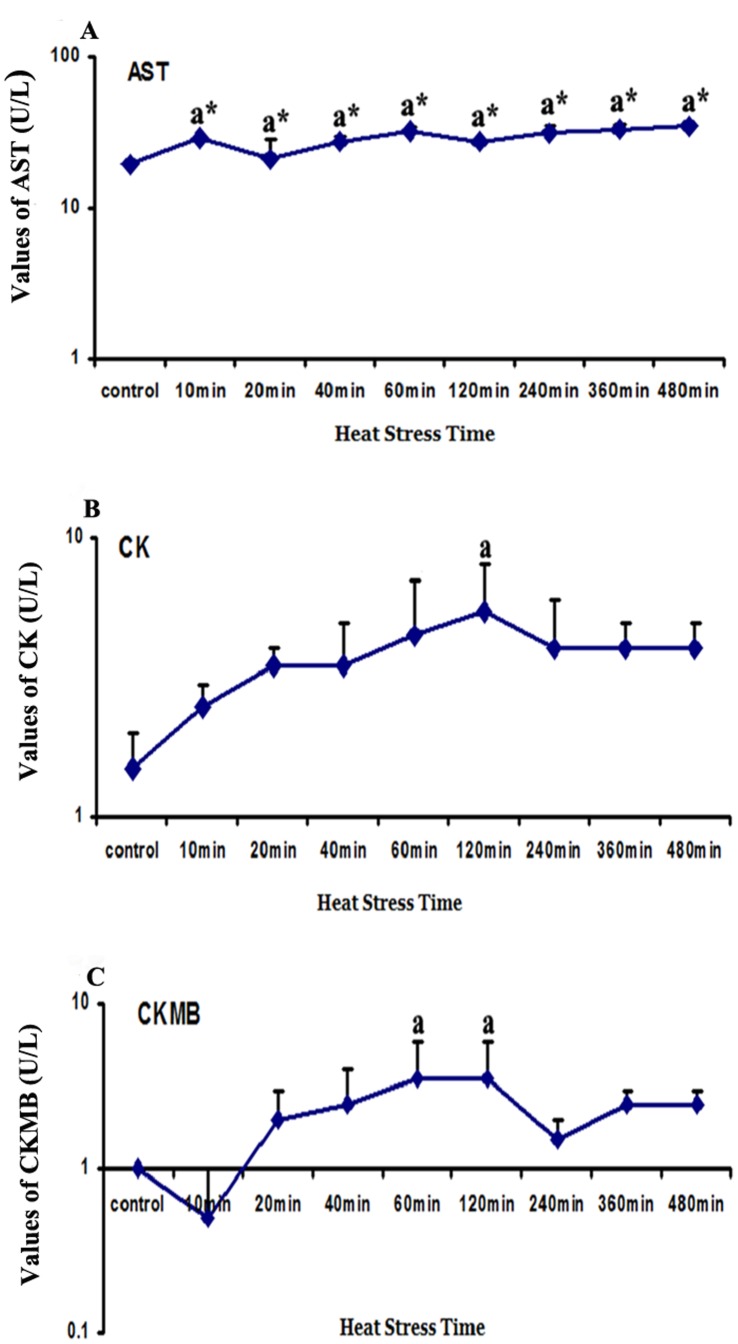
Time course of enzyme activities in the supernatant of myocardial cells exposed to heat stress.A: The activity levels of AST showed an obvious increase from 10 min of heat exposure at 42°C; B: The activity levels of CK showed an increasing tendency and decreased after 120 min of heat stress; C: The activity levels of CK-MB showed an increasing tendency, reached peak levels after 60 min and 120 min of exposure to heat stress, and then decreased after 120 min. a
P<0.05; a*
P<0.01.